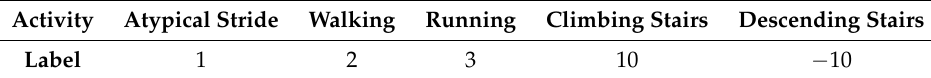
Table 5. Label definitions for activity recognition.